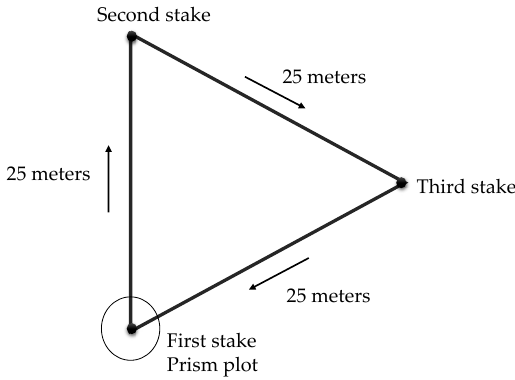
Figure 5. Schematic reconstitution of conventional NUWM triangular transect.